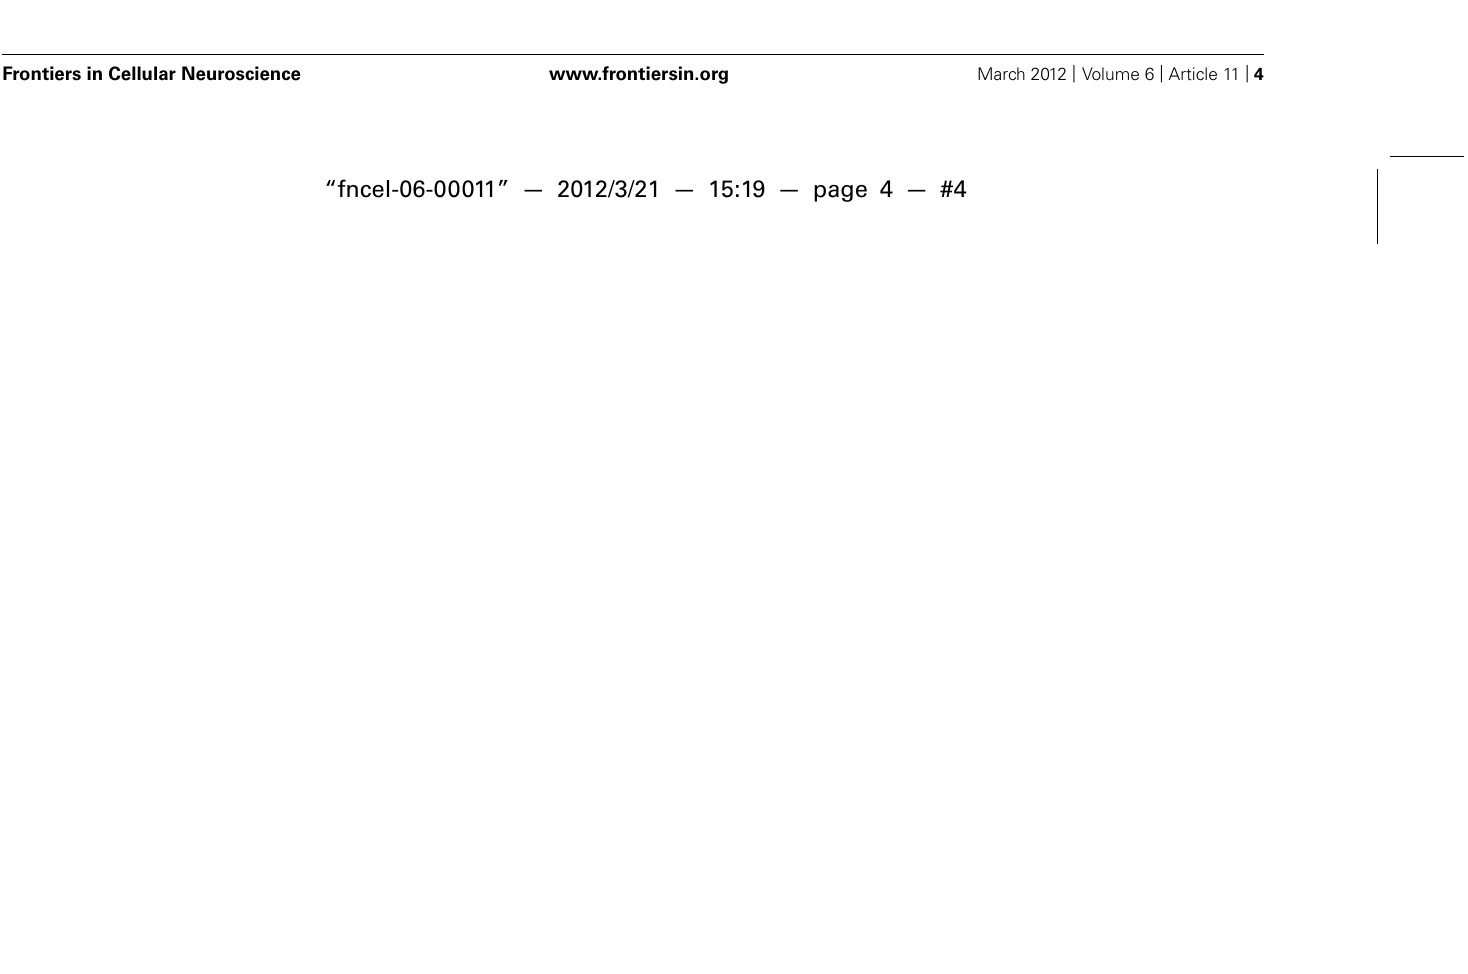
nuclei within the grafts showed that the cellular distribution was quite homogeneous ( Figure 4A ) with an average density of 2.46 ± 0.40 × 10 5 cells/mm 3 . When applying this across the